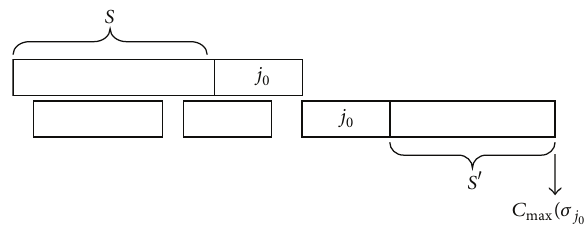
Table 5: Semipreemptive-based adjusted data of Example 2. Figure 8: Illustration of the permutation 𝜎 𝑗